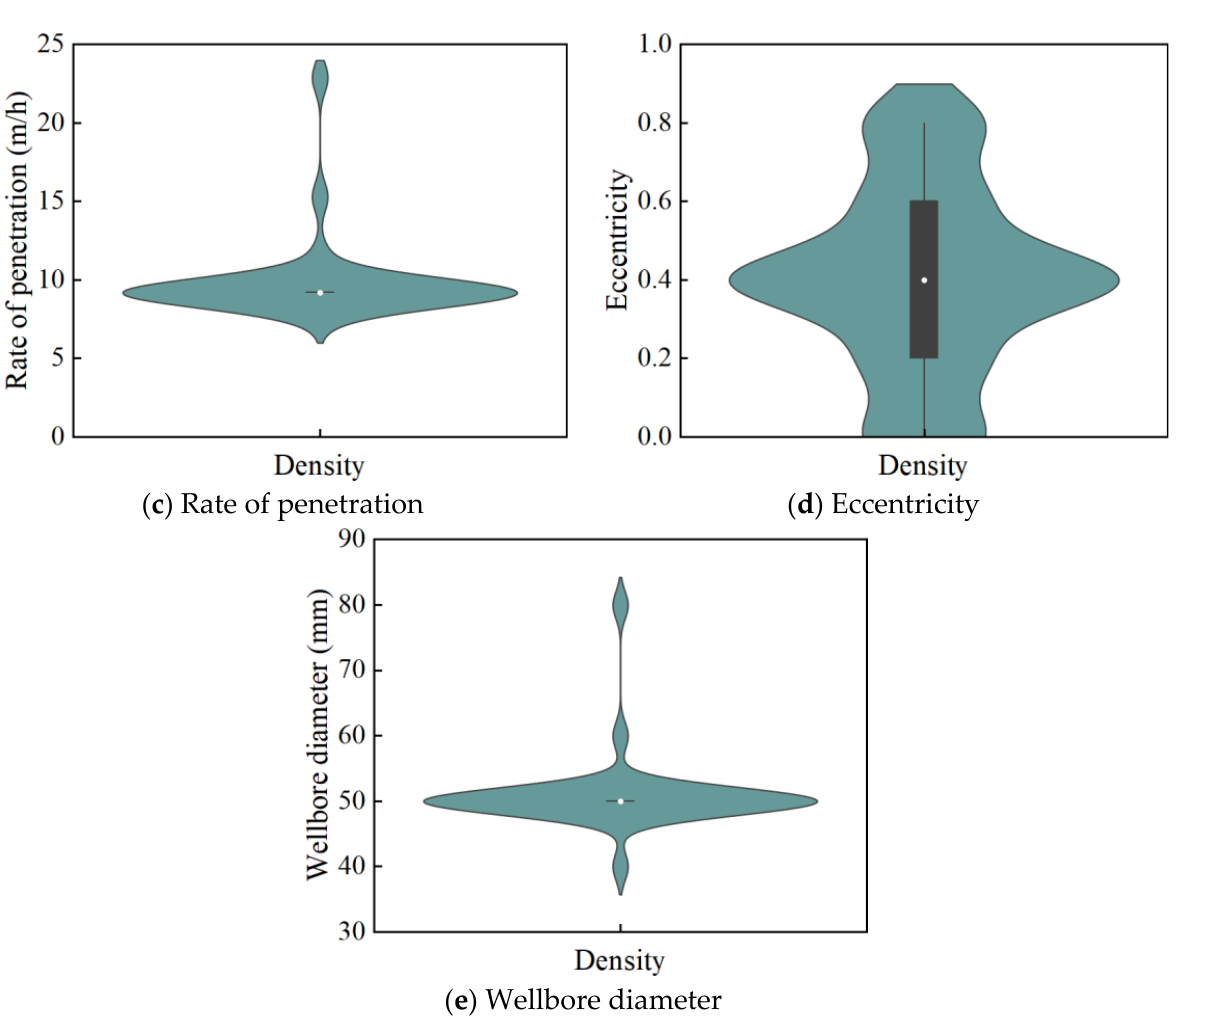
Figure 5. Density distribution and box plot of all the input features for the cuttings bed height prediction ( a ) flow rate, ( b ) cuttings diameter, ( c ) rate of penetration, ( d ) eccentricity, ( e ) wellbore diameter).